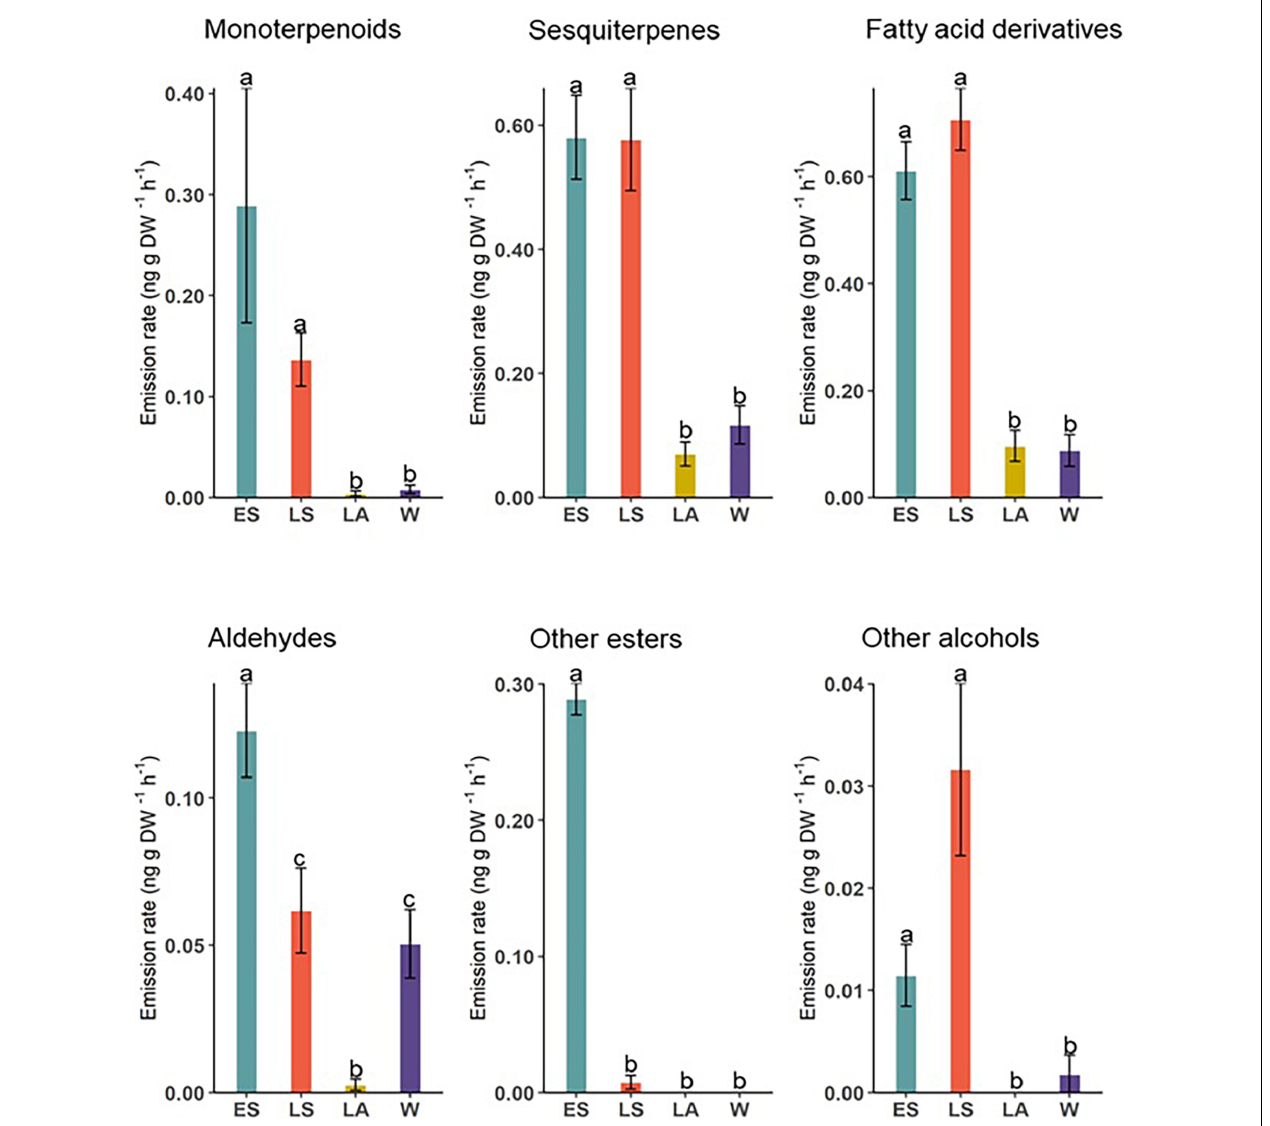
FIGURE 4 | Comparison of major chemical classes identified from D. subulatum in early summer (ES), late summer (LS), late autumn (LA), and winter (W). Bars show log-transformed mean ± SE emissions. Different letters indicate significant differences between groups ( n =